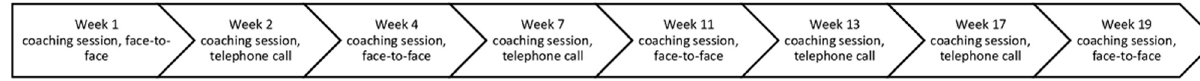
Figure 3. The 19-week coaching program.